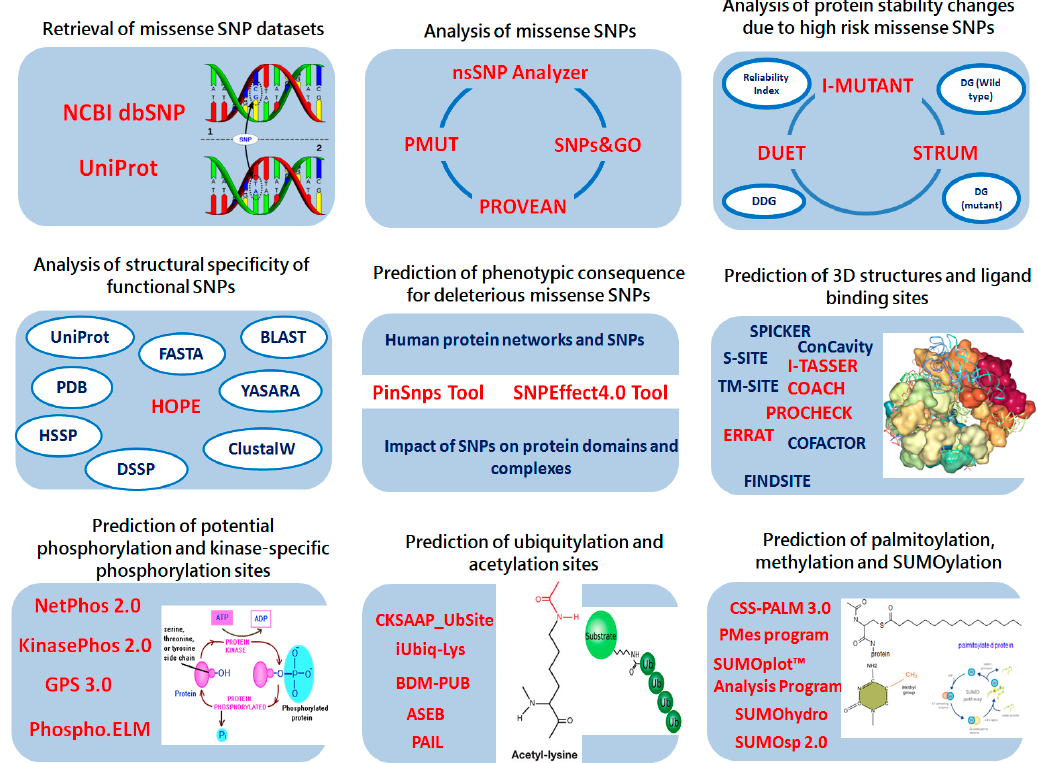
Figure 1. Schematic representation of prioritization pipeline. Identification of the most deleterious mutations in LC3A, LC3B, BECN1 and SCD1 based on various in silico tools. Abbreviations used: DG, free energy change; DDG, the predicted free energy change value.